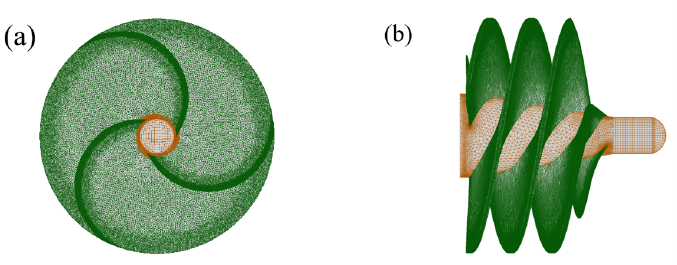
Figure 4. Detailed mesh distributions on the blade surfaces in ( a ) front view and ( b ) side